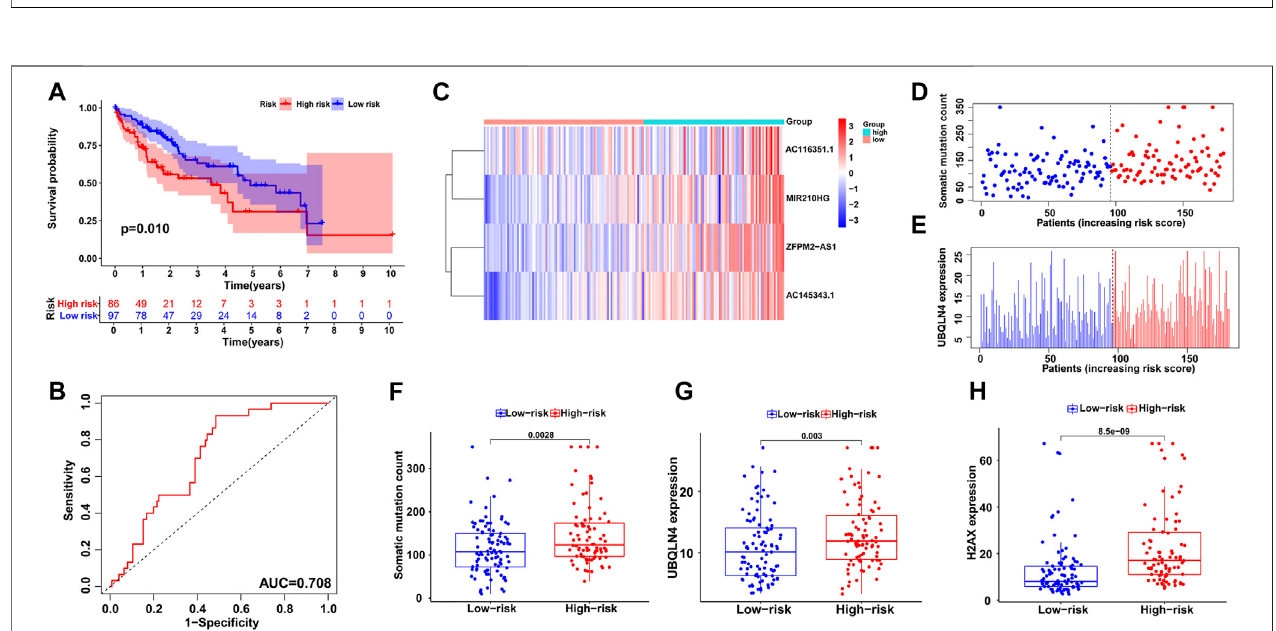
FIGURE 4 | Independent validation of the GILncSig in the testing group. (A) Kaplan – Meier survival analysis of high-risk and low-risk groups. (B) ROC curve to evaluate the performance of the GILncSig. (C) The expression pattern of the GILncSig in the testing group. (D) Distribution of somatic mutations with increasing risk score. (E) UBQLN4 expression with increasing risk score. The boxplots of the distribution of somatic mutations (F) , UBQLN4 expression (G) and H2AX expression (H) between the high-risk and low-risk groups in the testing group.